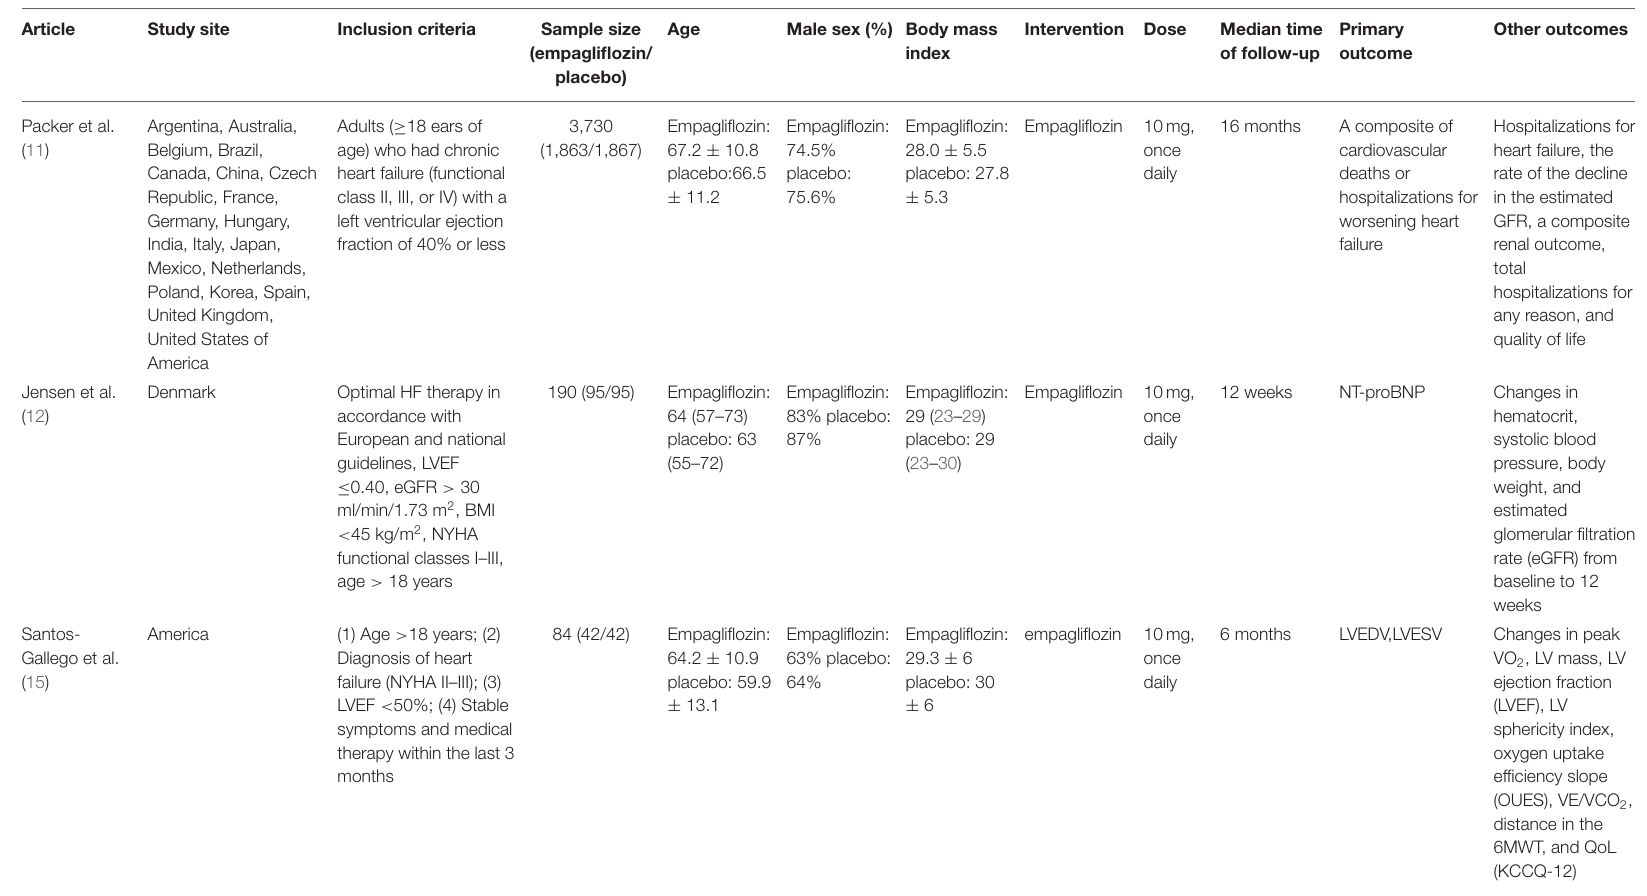
TABLE 1 | Characteristics of included